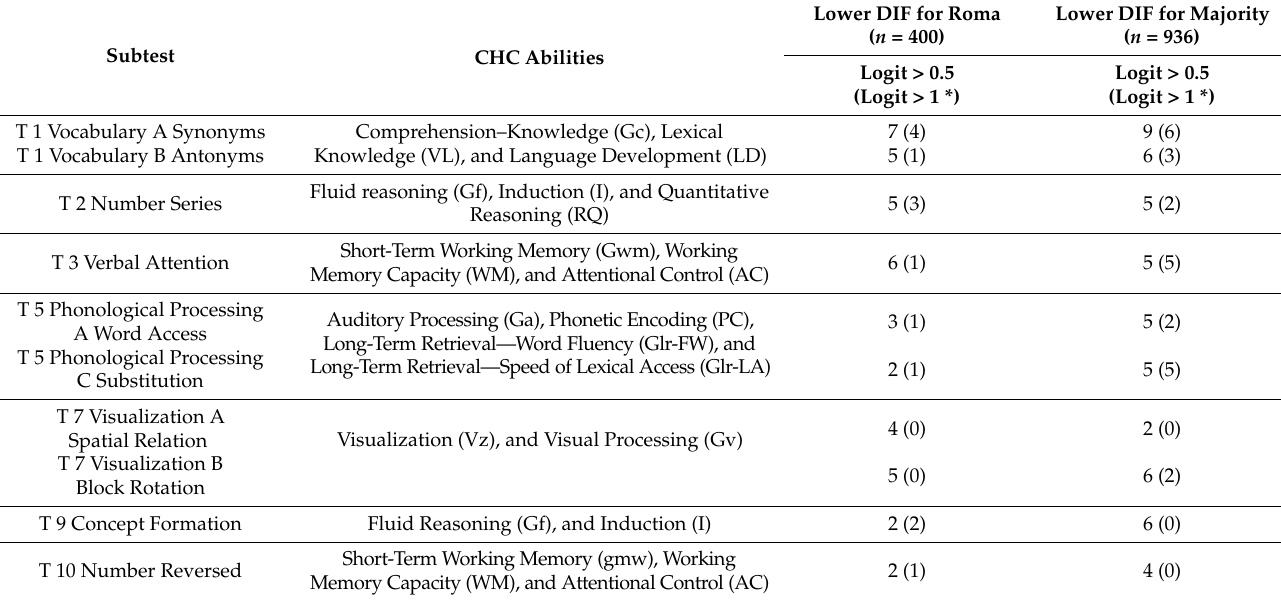
Table 1. The number of items with a different difficulty for majority children relative to Romani